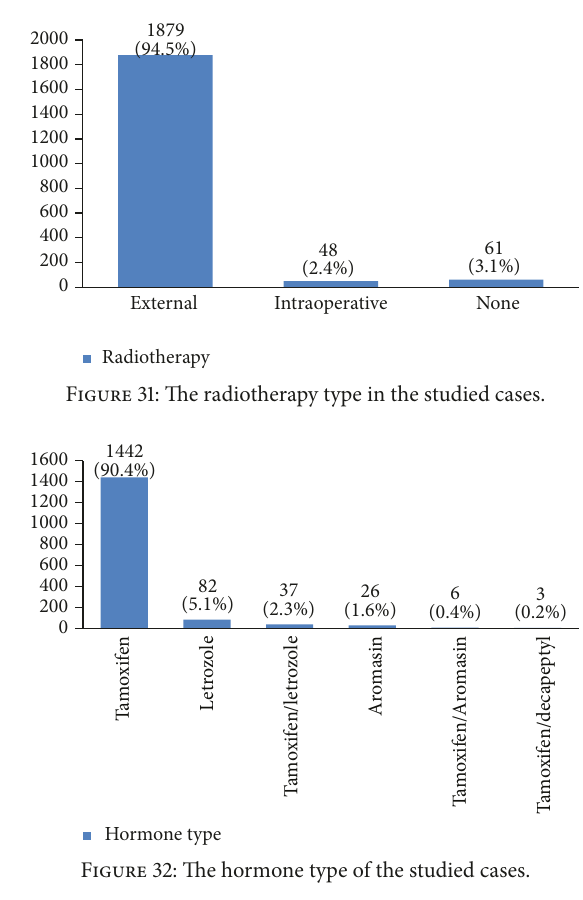
Figure 30: The chemotherapy type in the studied cases.